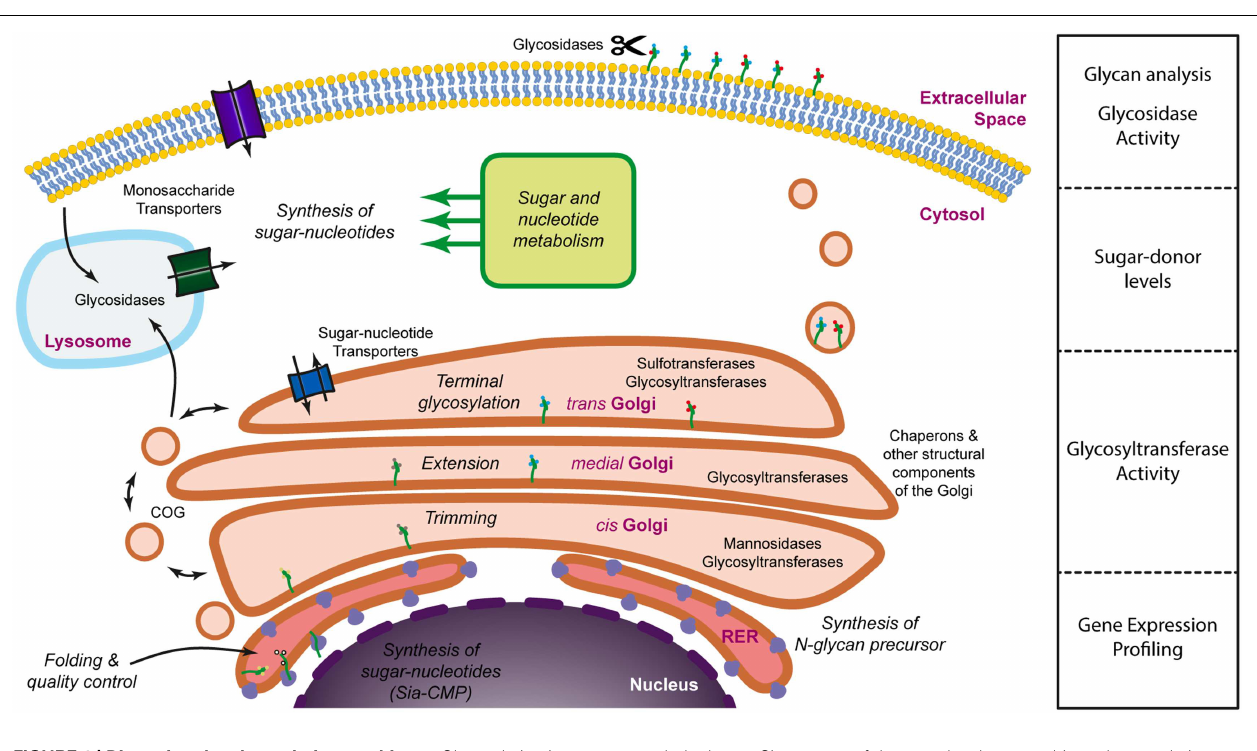
FIGURE 1 | Dissecting the glycosylation machinery . Glycosylation is a complex process that involves a large number of molecules and organelles.The glycosylation machinery can be defined as the set of enzymes, chaperones, transporters, sugar donors, and accessory molecules necessary for the modification of proteins or lipids with